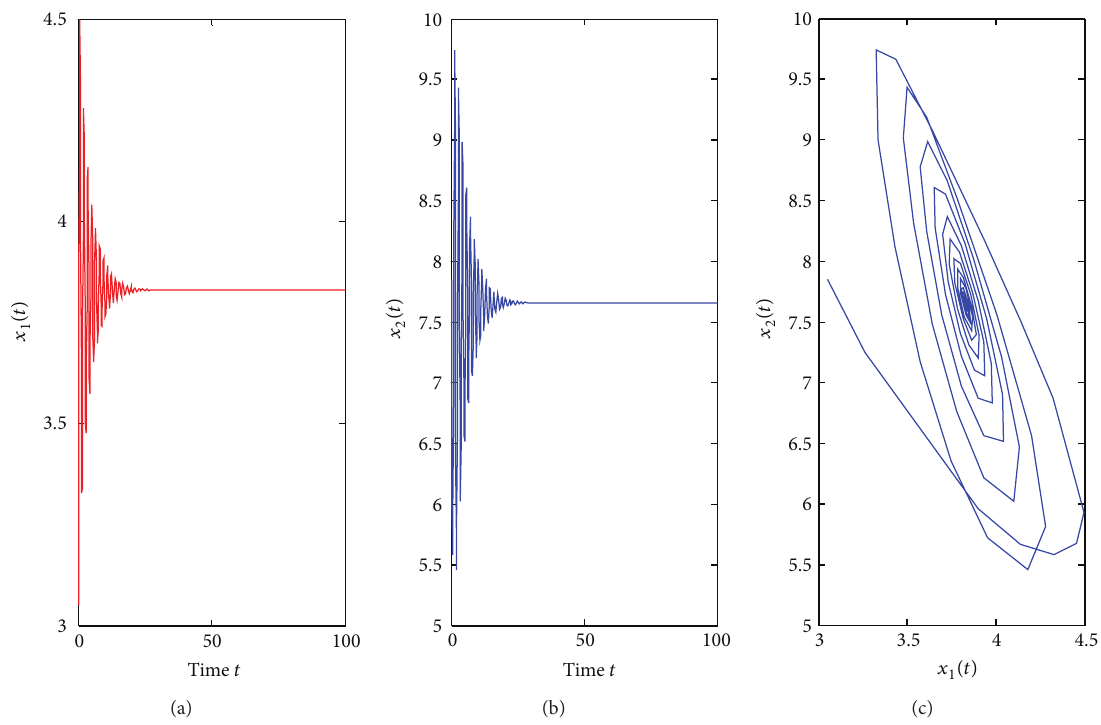
Figure 5: 𝐸 ∗ is asymptotically stable for 𝜏 = 0.320 < 𝜏 0 = 0.3361 .